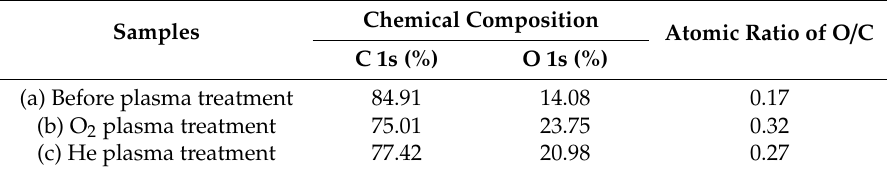
Figure 6. XPS overall scans of the ( a ) untreated, ( b ) oxygen, and ( c ) helium plasma-treated textile pile materials. Table 2. Relative chemical composition and atomic ratios of textile pile materials before and after plasma treatment.